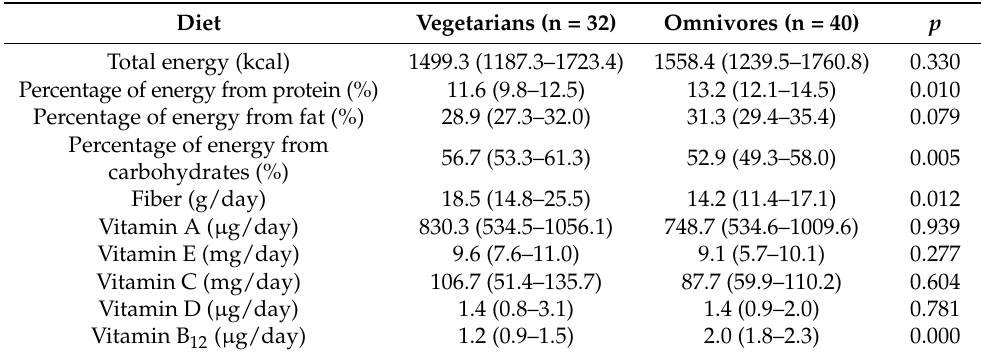
Figure 1. Correlations between serum GSH and GSSG in the whole group ( A ), vegetarian ( B ), and omnivorous ( C ) children. Table 2. Dietary intake of energy, macronutrients and vitamins in children on vegetarian and omnivore